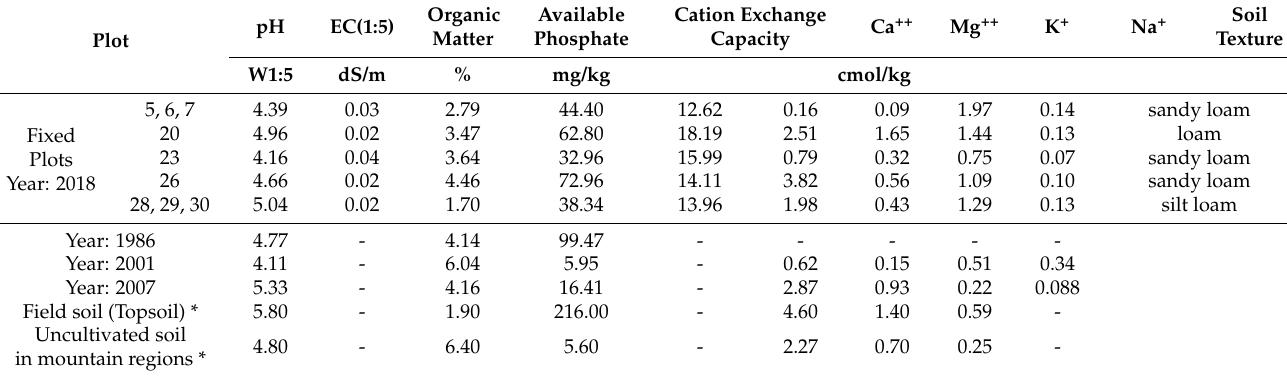
Table 2. Changes in physico-chemical properties of the soil in the forest of the Changdeokgung Rear Garden.